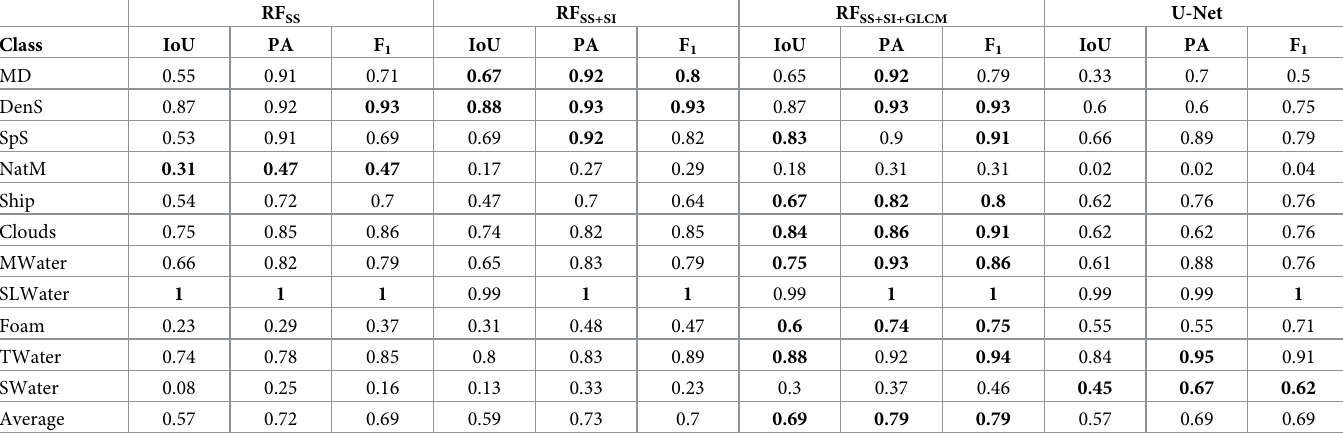
Table 4. Evaluation scores obtained by RF SS , RF SS+SI , RF SS+SI+GLCM and U-Net for each class on Marine Debris Archive. The highest scores are highlighted. All acro- nyms are stated in Table